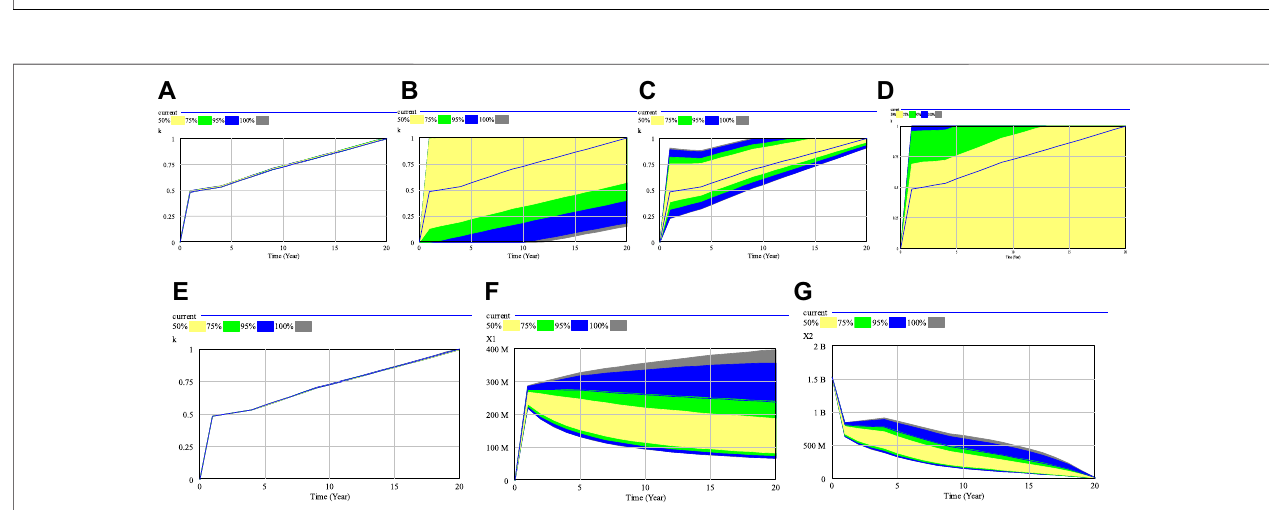
FIGURE 7 | Reality check: (A) Reality check on η 1, η 2, η 1s and η 2s; (B) Reality check on r1.